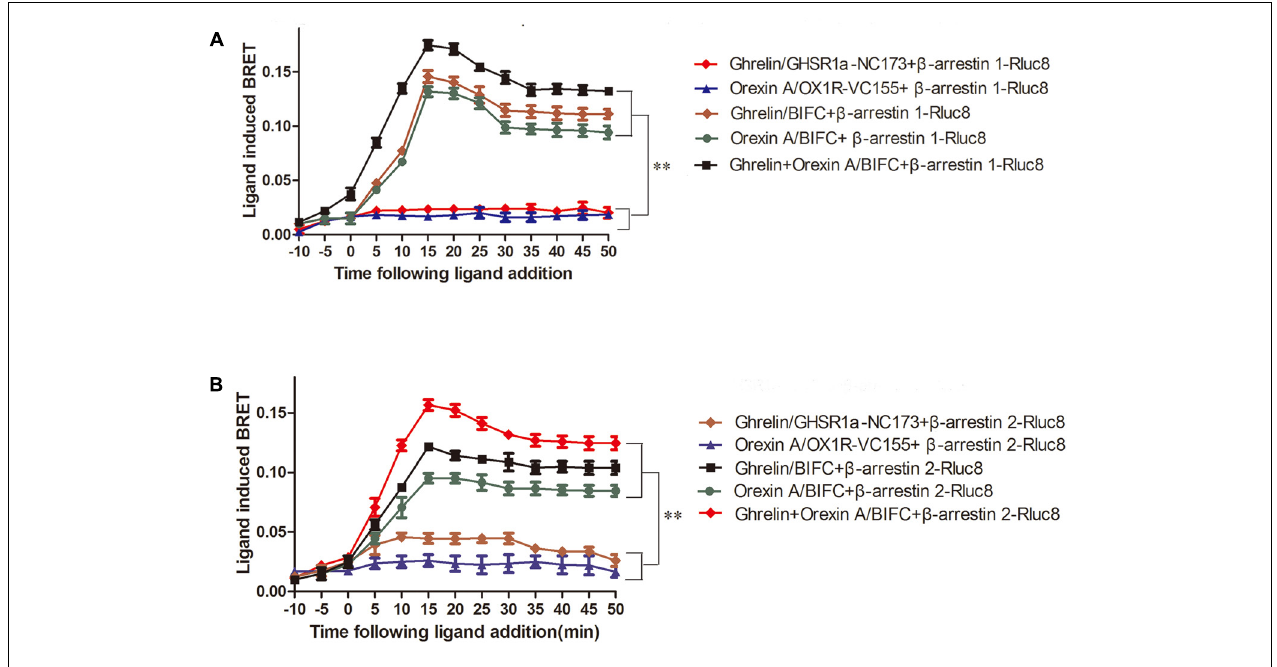
FIGURE 8 | Characterization of β -arrestin recruitment to GHSR1a/OX1R heterodimers. HEK293 cells transiently co-expressing BIFC (GHSR1a-VN173/OX1R-VC155) and (A) β -arrestin1-Rluc8 or (B) β -arrestin2-Rluc8 were assessed using BIFC-BRET to generate kinetic curves. Following the addition of 100 nM ghrelin and/or 100 nM orexin-A, the test continued for 50 min. The data points represent the mean ± SEM ( N = 3) of four independent experiments. The statistical analyses were performed with SPSS (version 19.0). The results of taking time 15, 25, and 35 min to analyze the results of four measurements show that there are statistical differences in different times. There was no significant difference between the control groups (two groups) and the experimental groups (three groups). The difference between the control groups and the experimental groups was statistically significant ( P < 0.01).